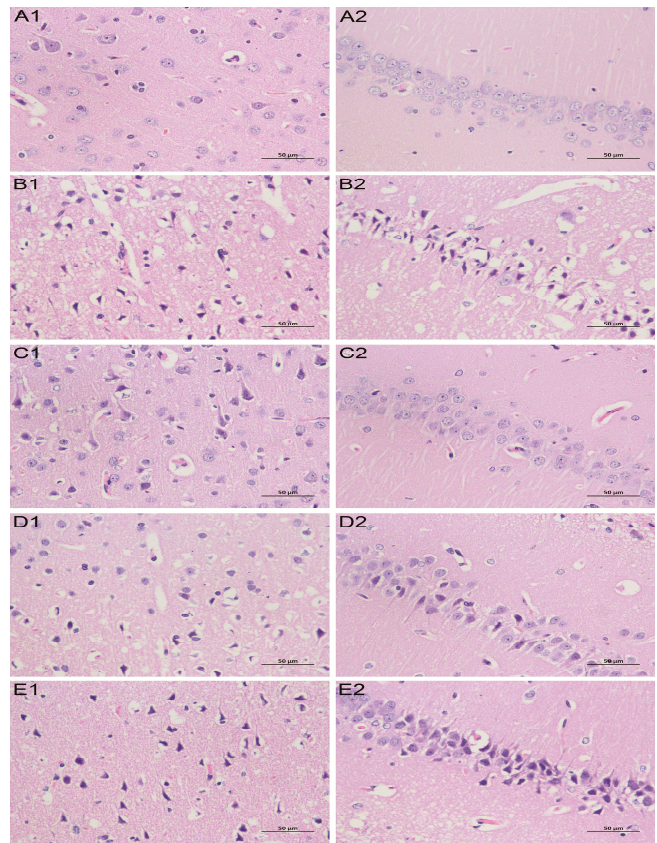
Figure 2. Hematoxylin-eosin (HE) staining results of brain tissue ( × 400): Nerve cells in the cerebral cortex for the control group ( A1 ), model group ( B1 ), nimodipine group ( C1 ), H-TCNDS group ( D1 ), and L-TCNDS group ( E1 ). Nerve cells in the CA1 region of hippocampus for the control group ( A2 ), model group ( B2 ), nimodipine group ( C2 ), H-TCNDS group ( D2 ), and L-TCNDS group ( E2 ). H-TCNDS meaned high dosage of TCNDS (316.34 mg·kg − 1 ·d − 1 ), and L-TCNDS meaned low dosage of TCNDS (158.17 mg·kg − 1 ·d − 1 ).